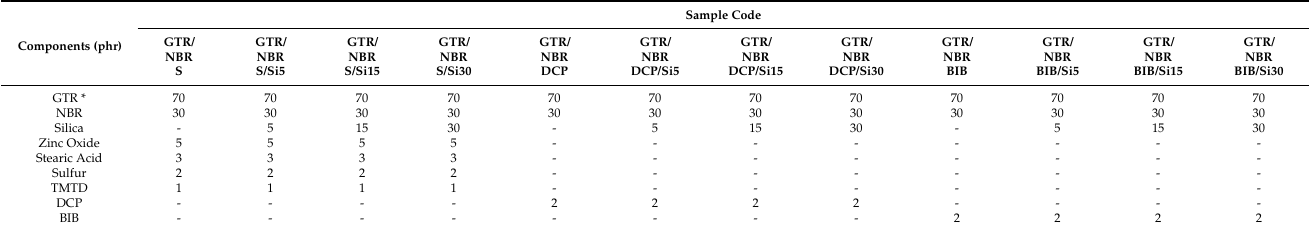
Table 2. The composition and coding of studied